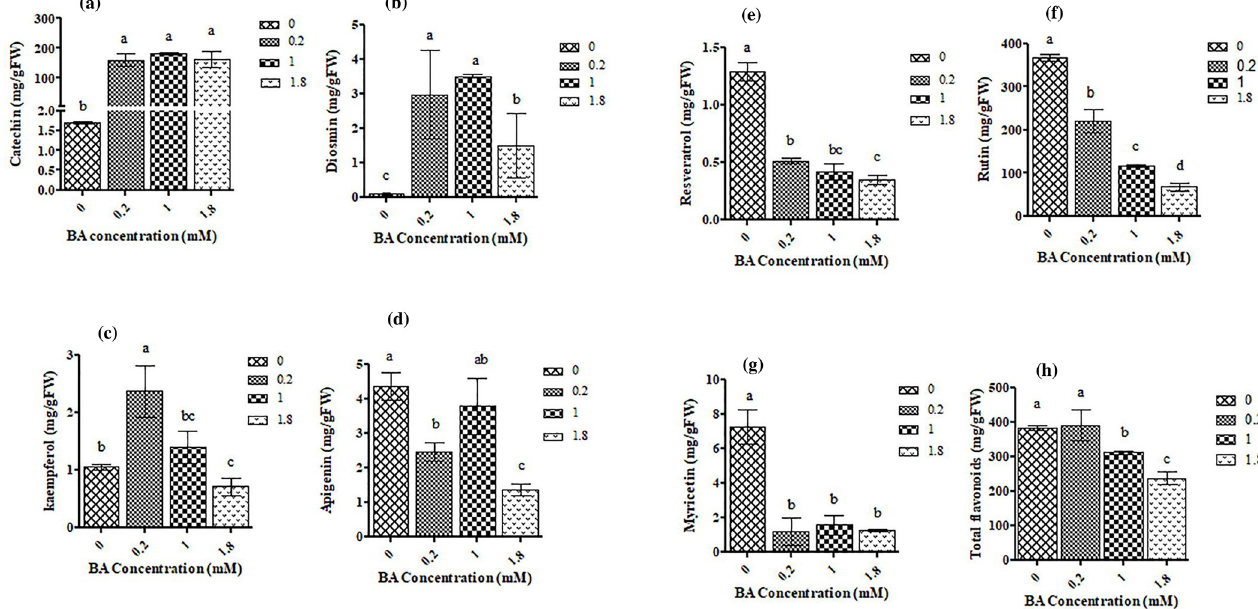
Fig 4. Alteration of C . tarraconensis flavonoids content in response to various concentrations of BA. Data are presented as mean ± SD, n = 3. Different letters show significant differences at P < 0.05 according to Duncan test.